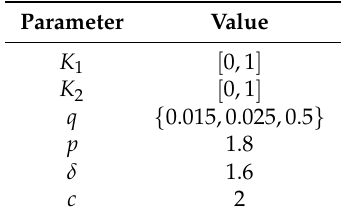
Table 2. Parameter values for numerical